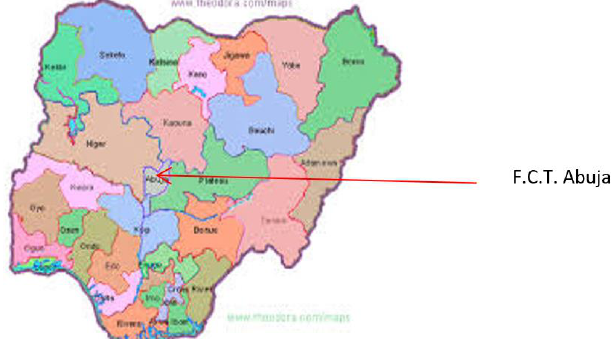
Figure 2. Map of Nigeria Showing 36 States and the FCT Abuja, Source: www.google.com